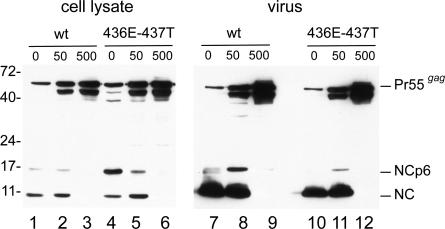
Analysis of Gag Polyprotein ProcessingWestern blot analysis of cell lysates (left panel) or virus particles (right panel) obtained by ultracentrifugation of cell culture supernatants from 293T cells transfected with the respective recombinant virus plasmids in the absence of inhibitor or in the presence of 50 or 500 nM of RO033-4649. Molecular mass standards are depicted on the left, Gag-derived proteins are identified on the right. Protein detection was performed following incubation with a specific antibody against NC.